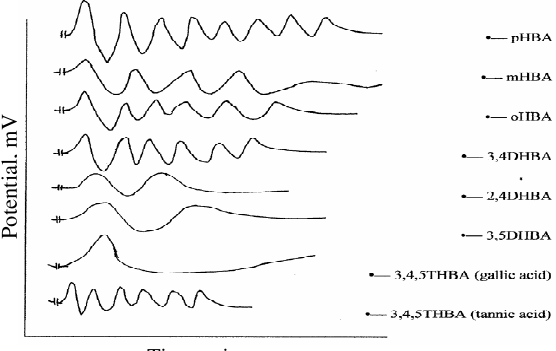
- ] = 0.0750 M; [Mn 2+ ] = 0.0080 M; in 1.0 M 3